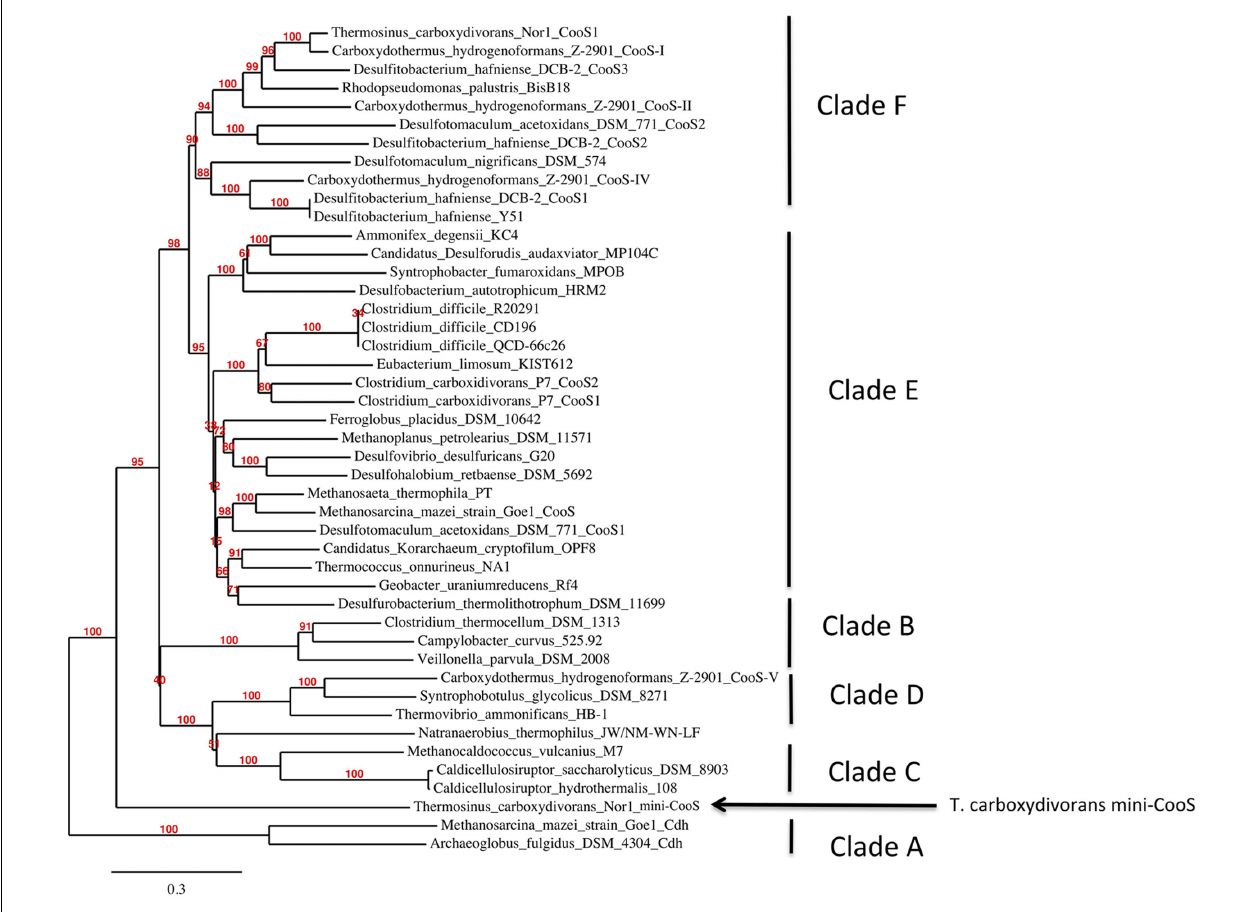
clades defined by Figure 1 as well as the mini-CooS from T. carboxydivorans . The tree was bootstrapped with 1000 replicates,which are shown as percentage values at the nodes in the